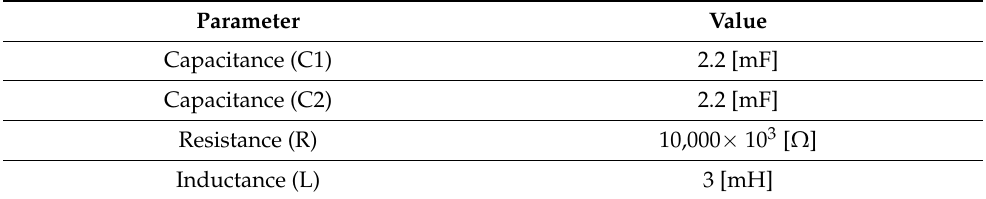
Table 3. Parameter of the buck converter